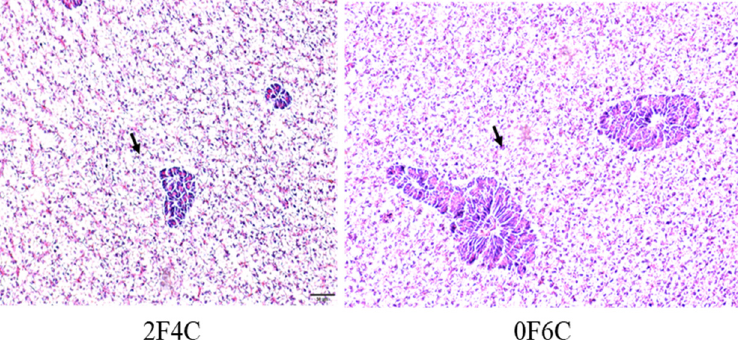
Figure 3. Cross-section in liver of red seabream fed experimental diets for 56 days. Arrows indicate small lipid droplets and lipid vacuoles of the hepatocytes. Hematoxylin and eosin (H&E) Staining, scale = 50 μ m).